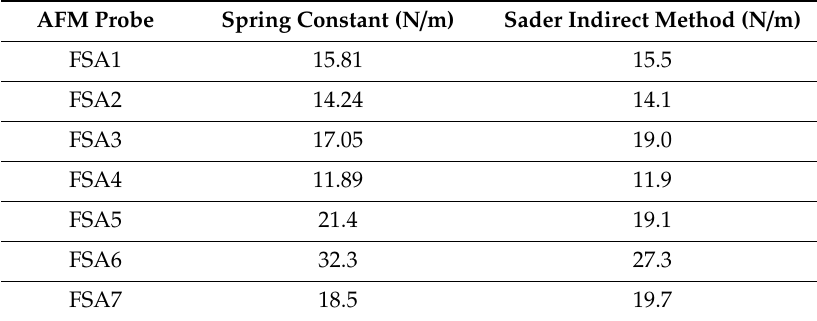
Table 3. Shows a comparison between the spring constant of the FastScan A cantilevers determined using the methods described in Slattery et al. [43] and Song et al. [49] and the Sader indirect method